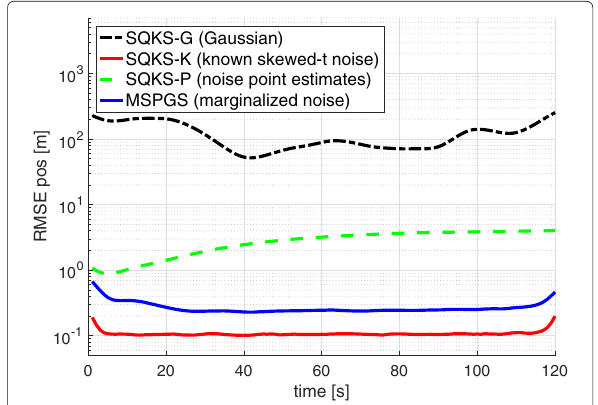
Fig. 4 Smoothing RMSE of position with ν =